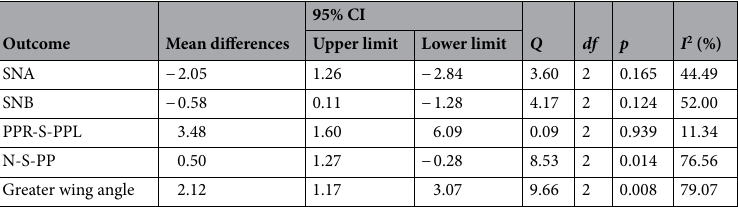
Table 3. Pooled mean differences and heterogenicity of each outcome. CI confidence interval.